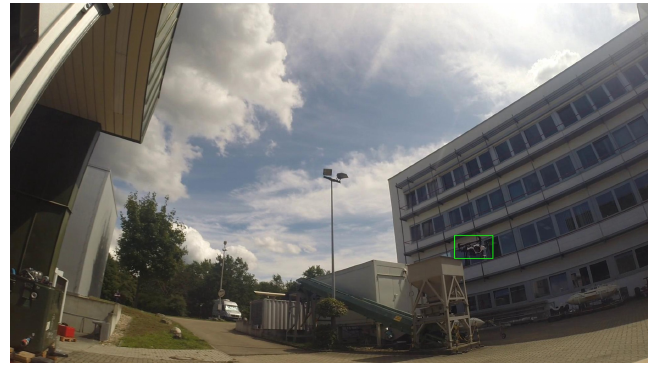
Figure 14. Drone detection is feasible in white and blue background.